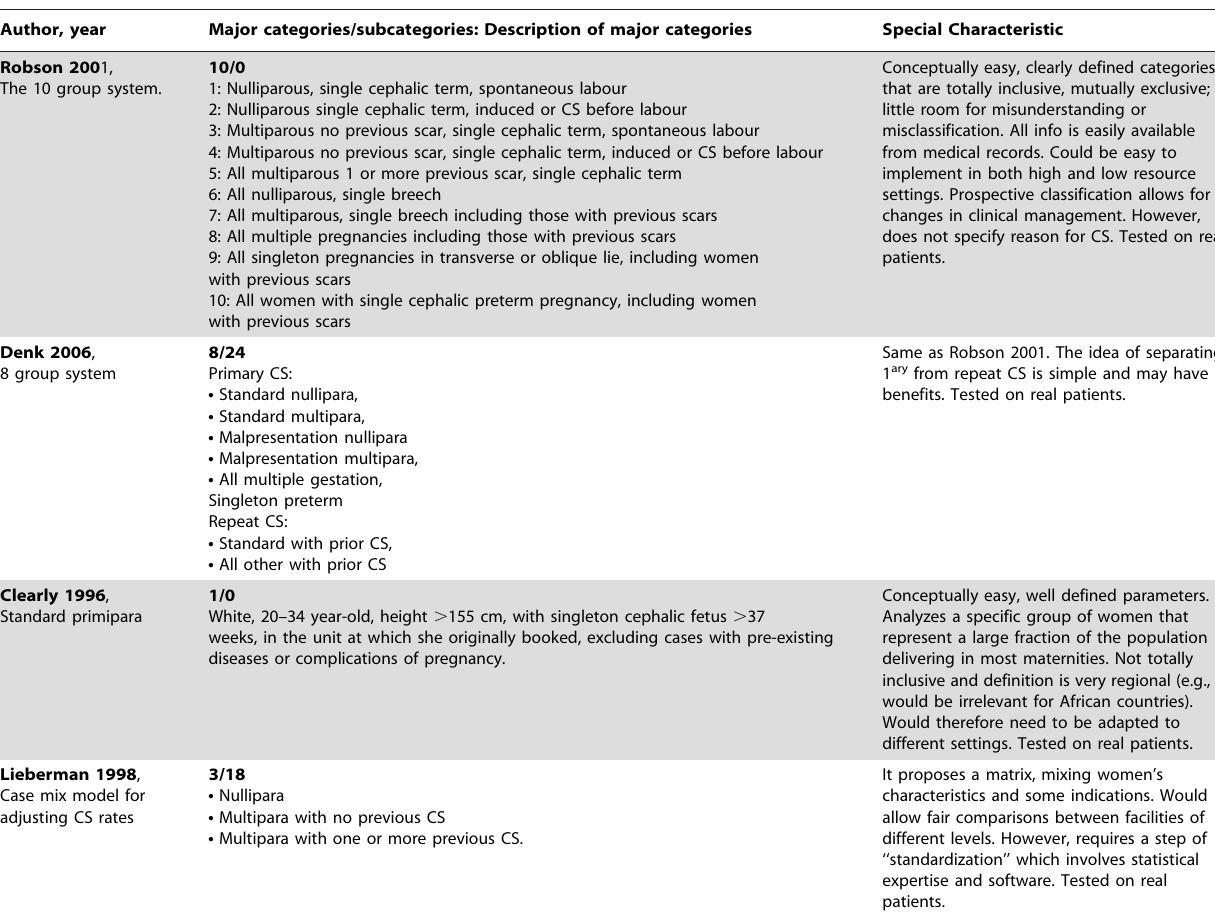
Table 6. Classifications for caesarean sections based on women’s